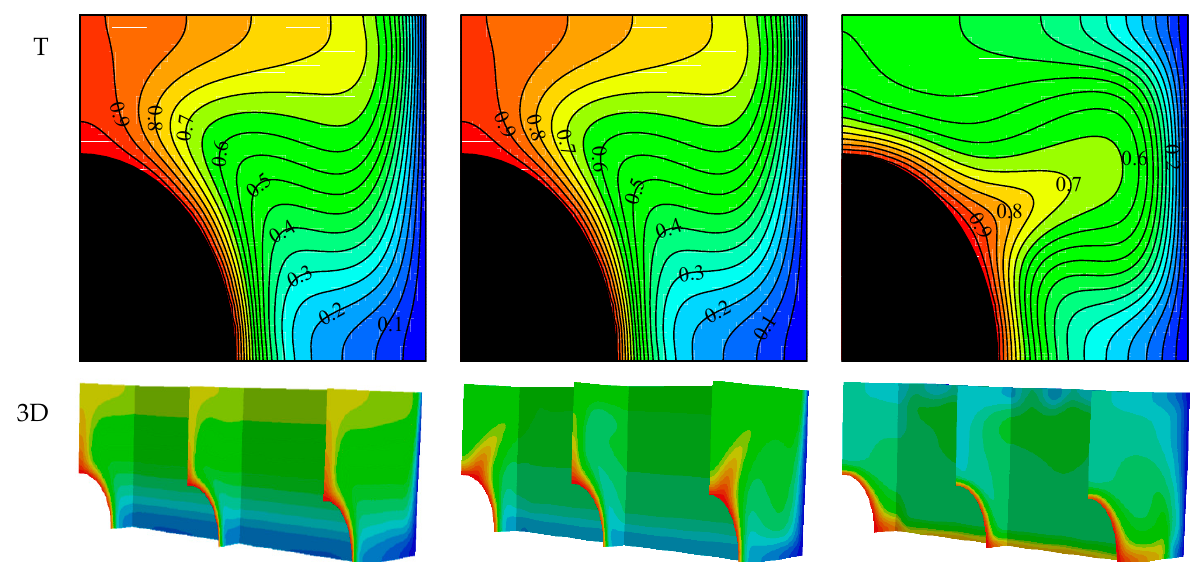
Figure 12. Stream and isothermal lines for Ra = 10 5 , Rd = 1, Ha = 20, AR = 0.45 − 0.6, γ = 45, ϕ = 0.03, and different cavity angles.